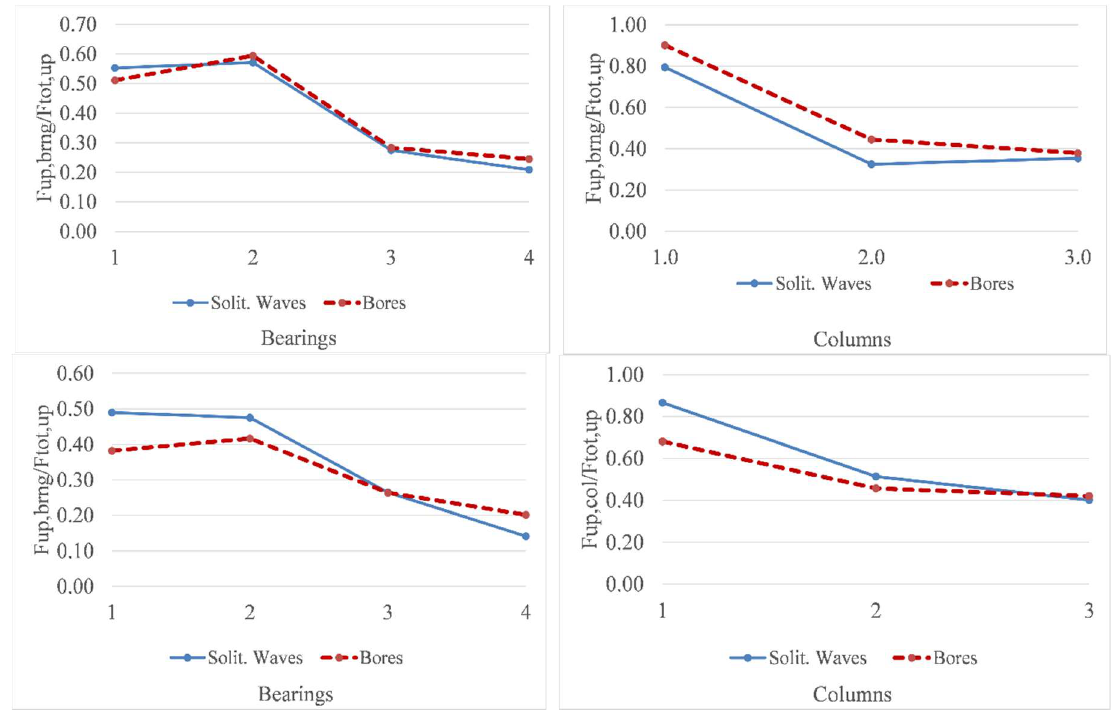
Figure 18. Envelopes of maximum normalized uplift forces in bearings ( left ) and columns ( right ) of the deck with cross-frames ( top ) and the one with solid diaphragms ( right ).